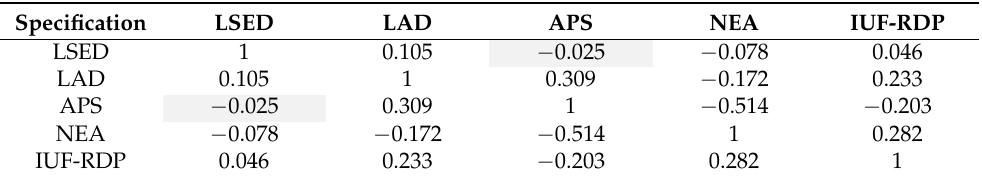
Table 5. Dependencies between selected conditions for the development of sustainable agriculture and the level of use of proenvironmental RDP funds. Source: own elaboration. Specification